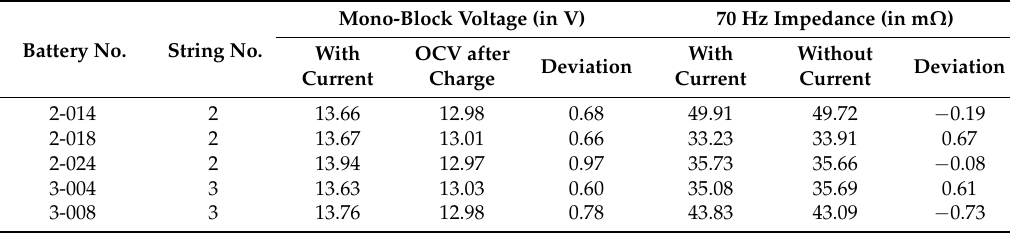
Table 2. Results of charge current influence measurement on impedance registered by LEM Sentinel 2. Charge currents at time of measurement were: 10.4 mA for string 2 and 12.4 mA for string 3. Batteries came from float charge into pause phase and voltage relaxation was